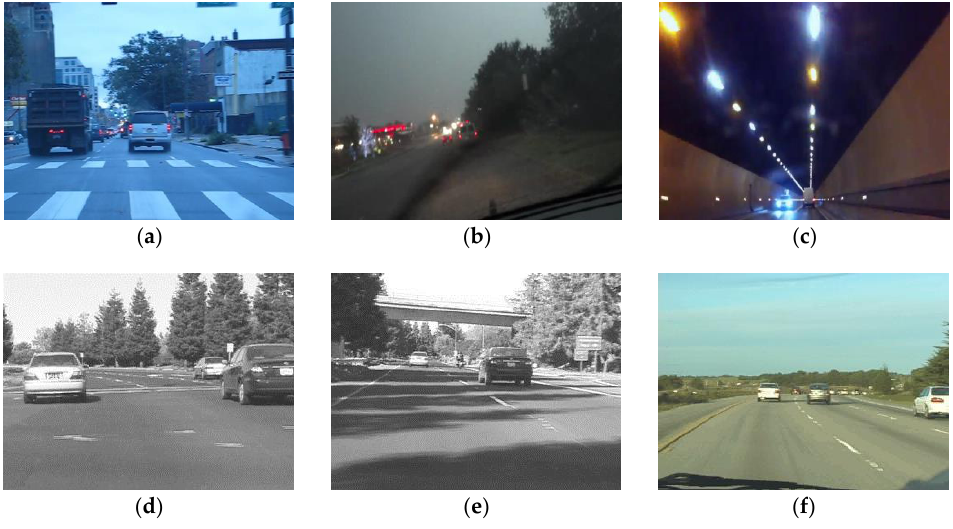
Figure 9. Sample frames of test video sequences: ( a ) BlurCar1(2); ( b ) Wiper; ( c ) Tunnel; ( d ) Car1(1); ( e ) Car1(2); ( f ) Car24. Table 3. Test video sequences.